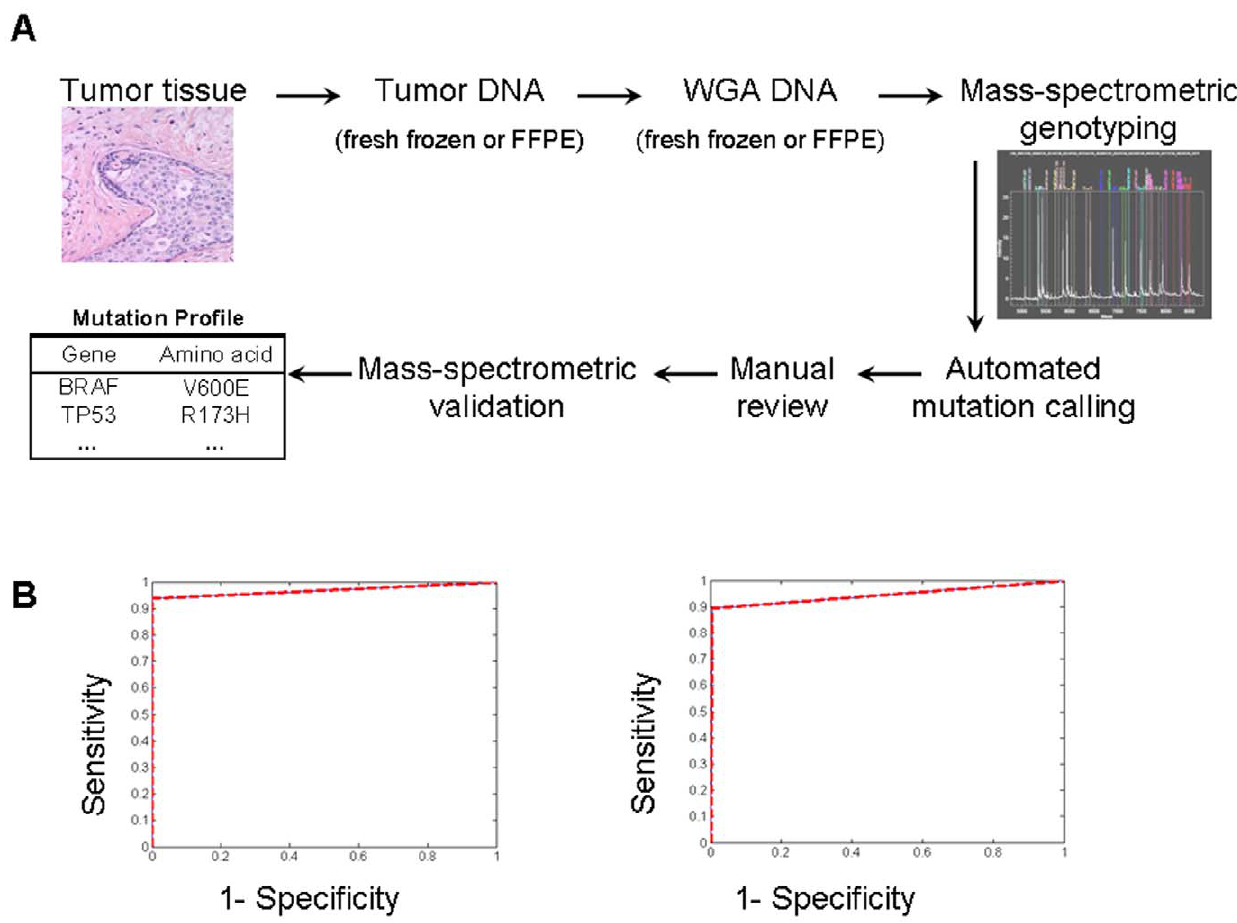
Figure 1. The OncoMap process and performance in fresh frozen and FFPE-derived DNA. A. An overview of the OncoMap process from tumor to mutation profile. See text for details. B. Receiver operator characteristic curves (ROCs) show the sensitivity and specificity for various cutoff values on the sample score of the validation samples. ROCs are plotted for fresh frozen (left) and FFPE-derived (right) DNAs, using bidirectional KRAS assays and Illumina data as a truth-set (see Methods S1).